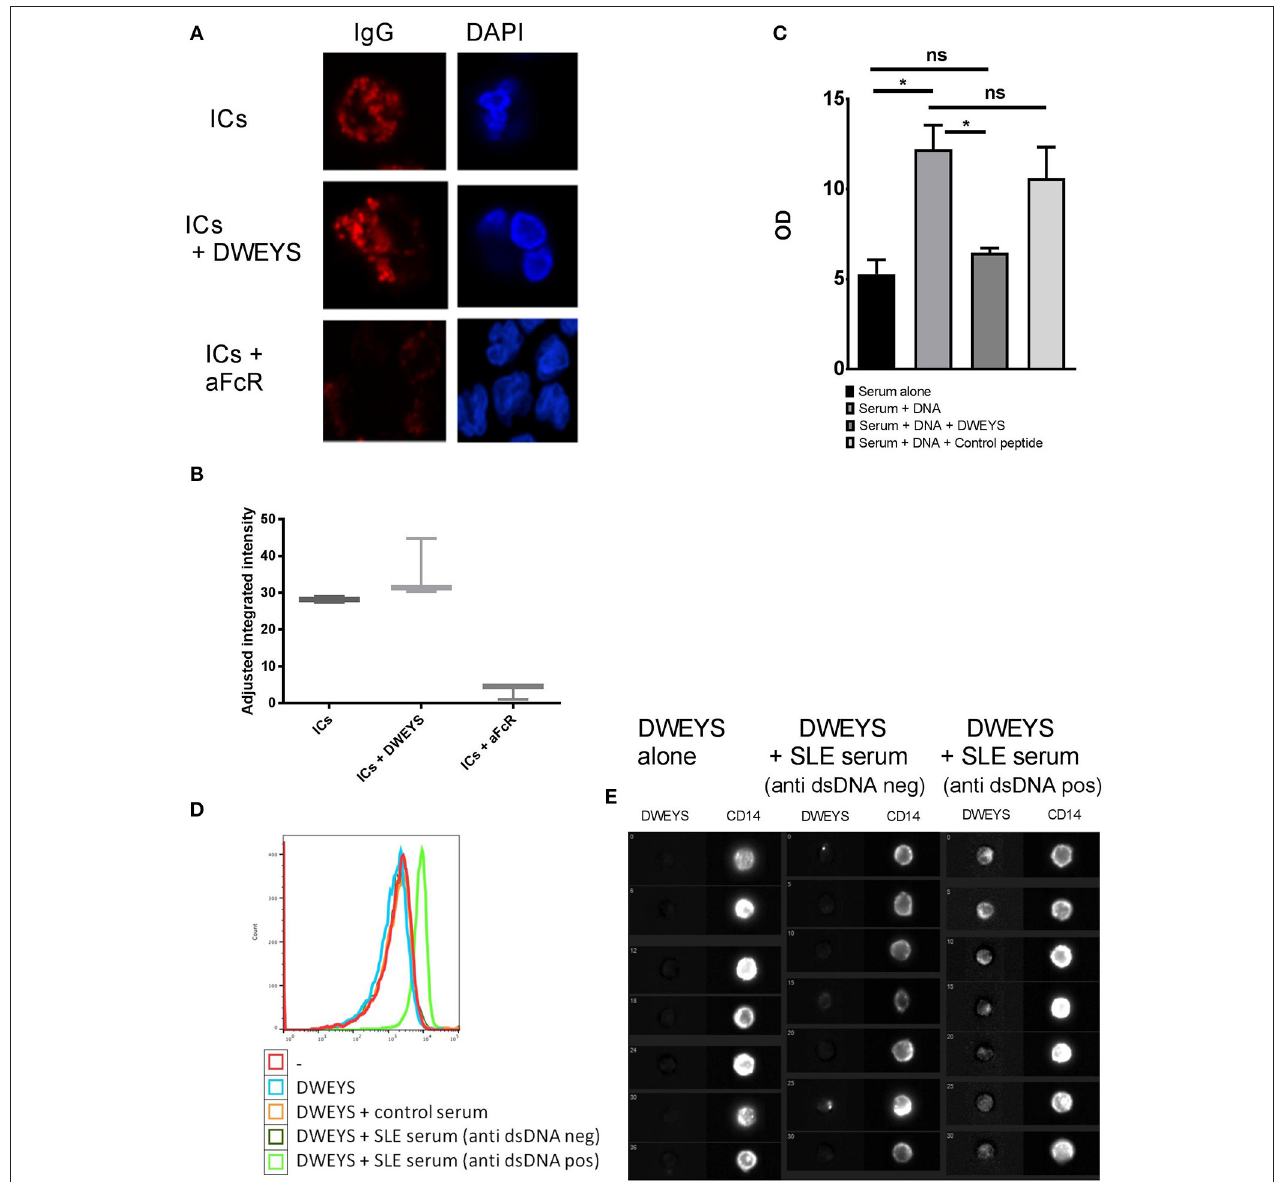
FIGURE 3 | DWEYS displaces DNA from immune complexes and inhibits DNA internalization into monocytes. (A) Primary human monocytes were incubated with labeled heat aggregated human lgG (hlgG, red) and either DWEYS or a blocking anti-FcRIIa antibody for 20 min. Cells were counterstained with DAPI and imaged using a laser scanning confocal microscope. (B) The graphs indicates adjusted fluorescence intensity for three experiments. (C) SLE serum was incubated with Syto 60 labeled dsDNA (5 µ M), followed by DWEYS or control peptide (100 µ M) for 30 min each. lgG was then isolated on protein G beads and Syto60 levels from protein G beads were quantified using LICOR scanner. OD was normalized to a standard labeled and filtered DNA. Results indicate mean ± SD of three independent experiments. (D,E) Primary human monocytes were incubated with biotinylated DWEYS alone or biotinylated DWEYS and SLE serum from patients with or without anti ds DNA antibodies for 20 min. Cells were then stained for CD 14 as a membrane marker and intracellular DWEYS was tagged using fluorochrome labeled streptavidin. Intracellular DWEYS was quantified using lmageStream instrument: DWEYS fluorescence levels by flow cytometry (D) and representative ImageStream cell images (E) . One representative experiment of three with similar results is shown. * p < 0.05; ns, not